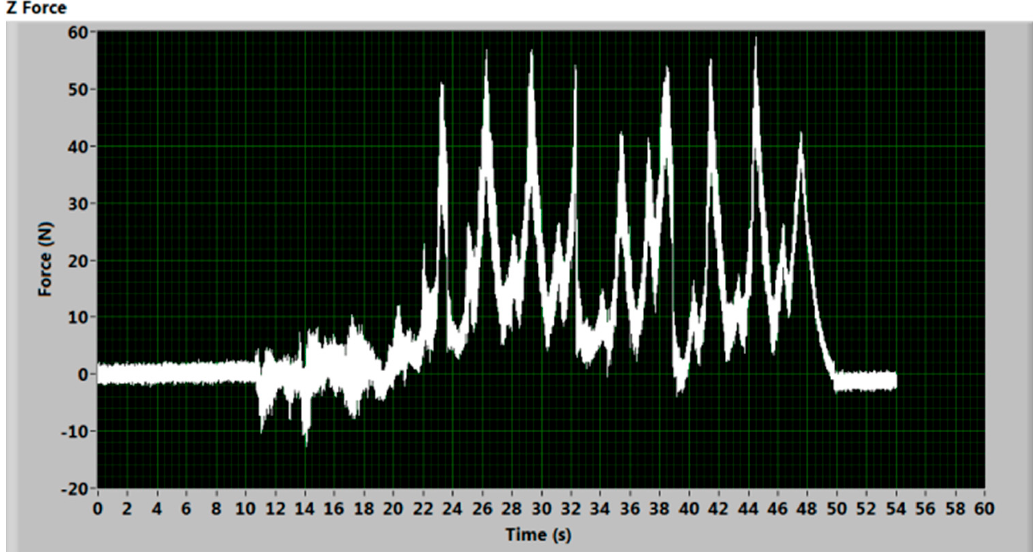
Figure 10. Cutting force signal from cutting with a pump with a damaged seal in one side of the multiplier; the cut material was steel 1.0547 (St 52-3), traverse speed 50 mm/min.